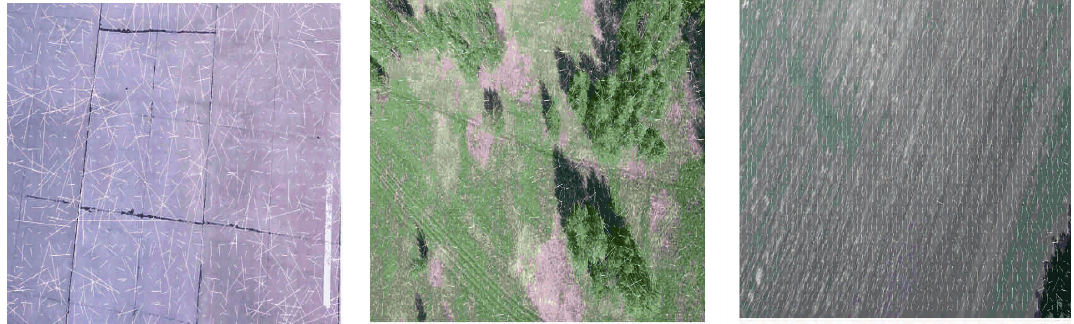
Figure 3. Optical flow estimated at landing with averaging 2 × 2 at the altitudes 195 m ( right ), 50 m ( centre ), and 20 m ( left ).